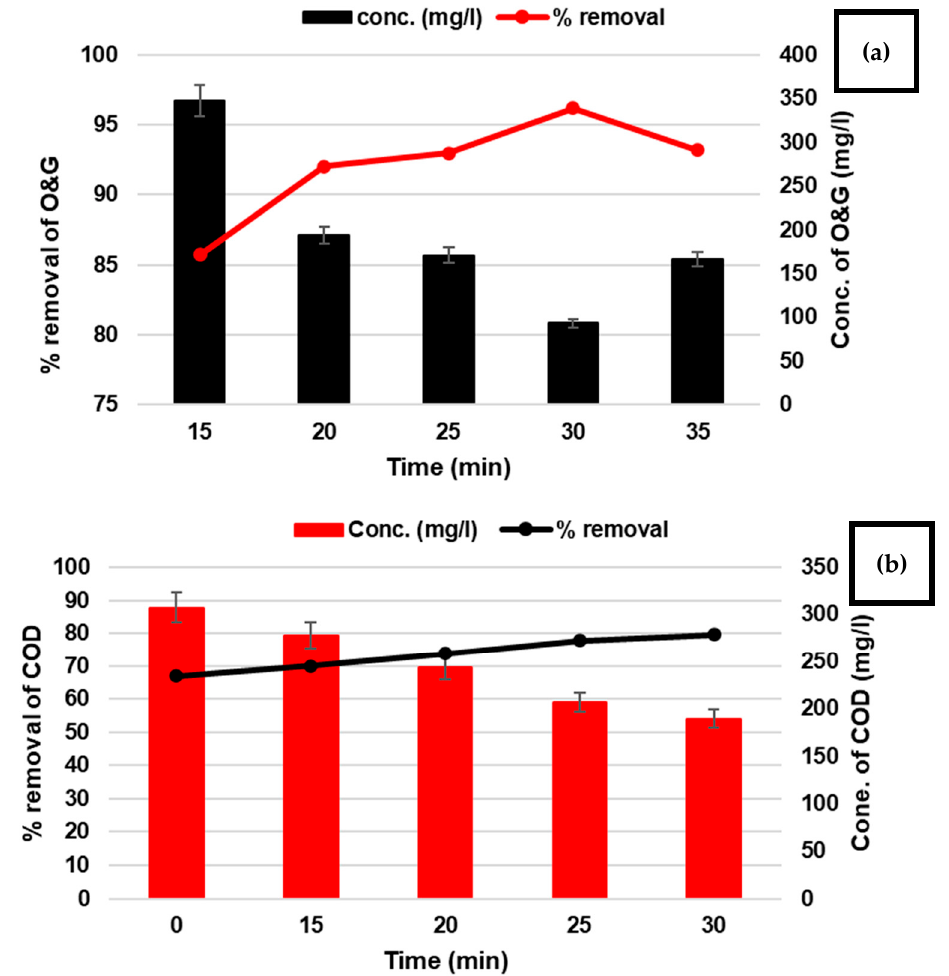
Figure 4. The effect of T on the (%) removal efficiency and concentration of ( a ) O&G and ( b ) COD using the EC process with a constant interelectrode distance of 2 cm and 50 A/m 2 current density.